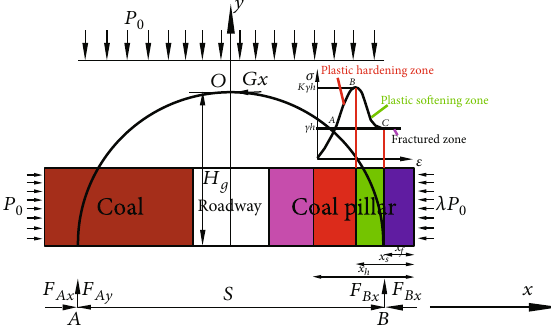
Figure 7: Mechanical model of stress arch